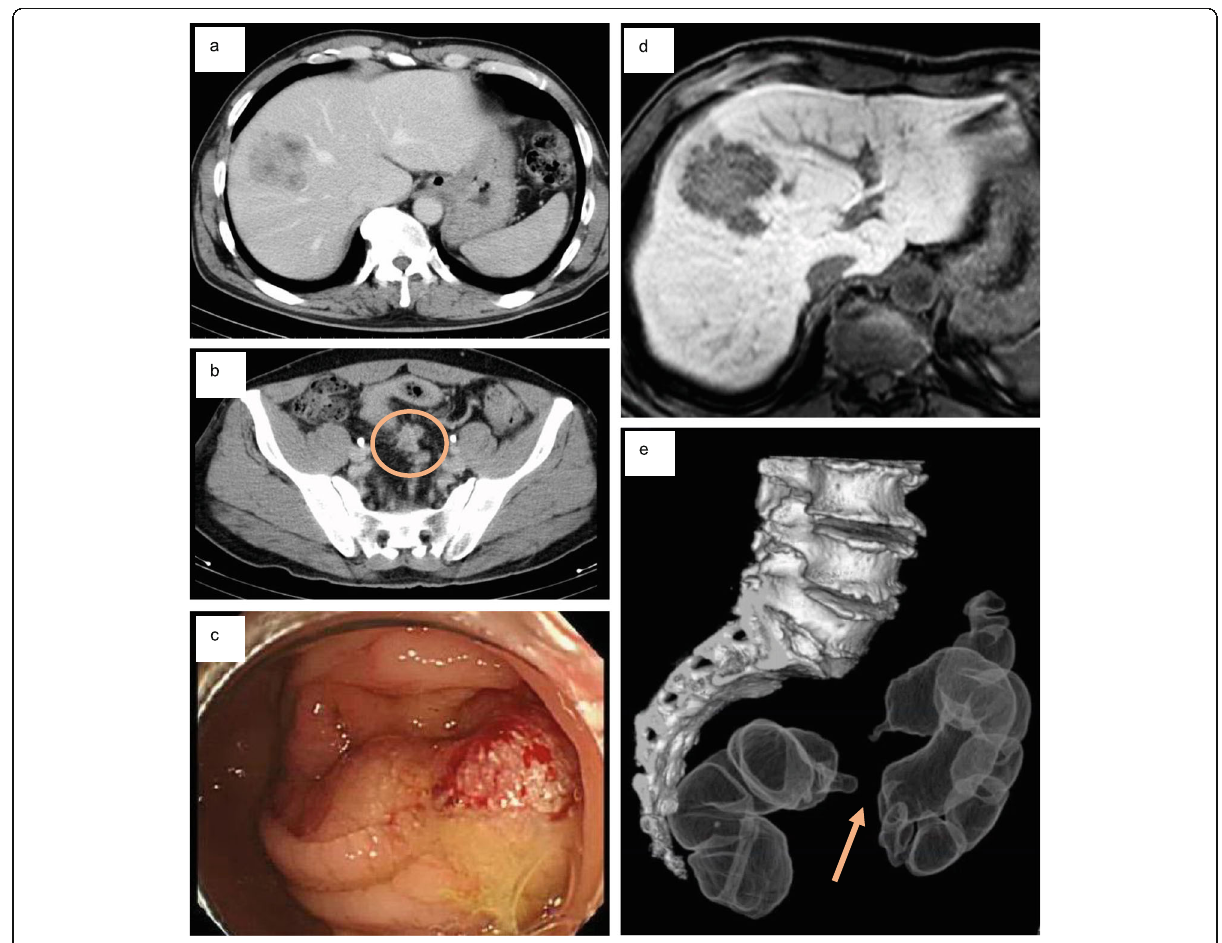
Fig. 1 Pretreatment computed tomography (CT), magnetic resonance imaging (MRI), and colonoscopy. a Axial view of a liver metastasis on contrast-enhanced CT. b Axial view of regional lymph node metastases (circle) on CT. c Primary sigmoid colon cancer on colonoscopy. d Axial view of a liver metastasis on ethoxybenzyl diethylenetriamine-enhanced MRI. e Primary sigmoid colon cancer on